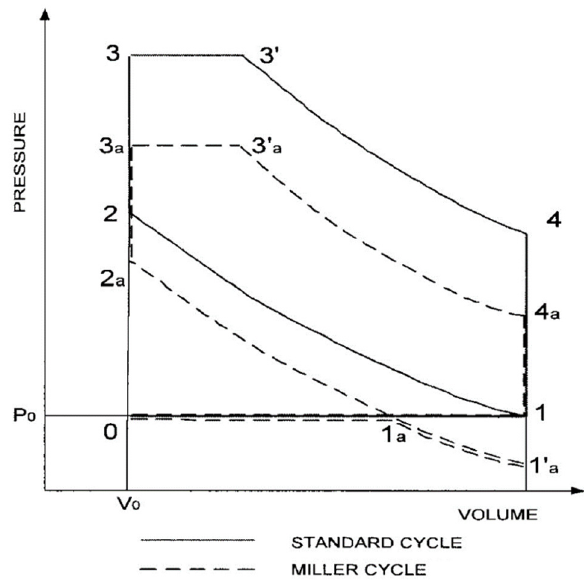
Figure 1. Miller cycle and standard cycle for diesel engine .